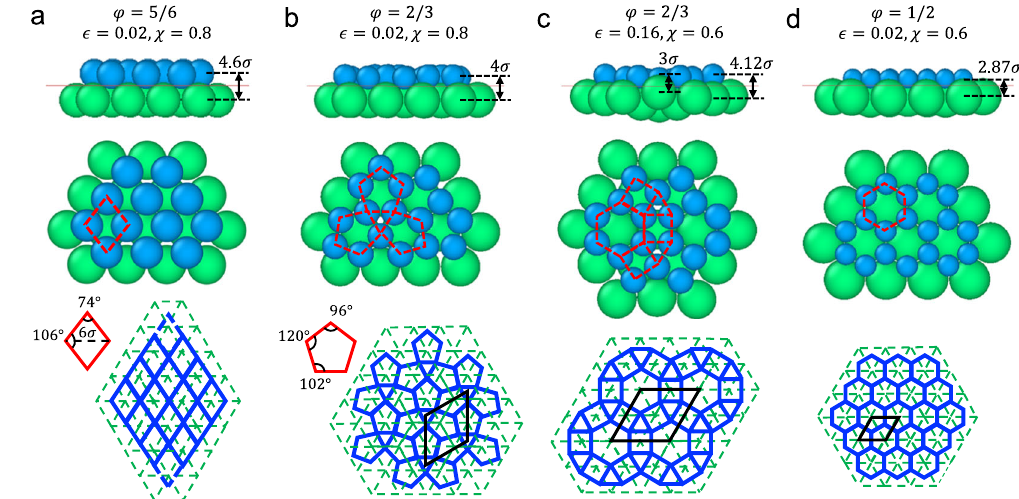
Fig.5|HybridbilayerBNSLsformedatdifferentNPsizeratios. LargeNPsforma hexagonal sheet on which small NPs organize into: a quasi-periodic rhombic arrangement at φ =5 = 6; b periodic tessellation of slender pentagons and triangles at φ =2 = 3,yieldinganA 3 B 5 -typeBNSL; c periodictessellationofhexagons,squares,